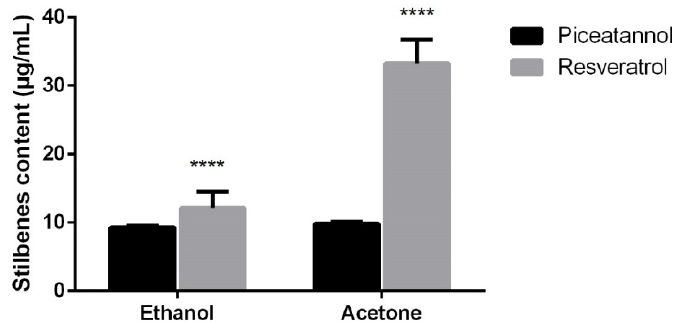
Figure 3. Piceatannol and resveratrol content ( μ g/mL) in ethanol and acetone extracts obtained with ultrasound method. Results are expressed as Mean ± SD. Statistical comparisons were made using one-way ANOVA, followed by the Tukey’s multiple comparisons test. Values significantly different from piceatannol (**** p < 0.05).